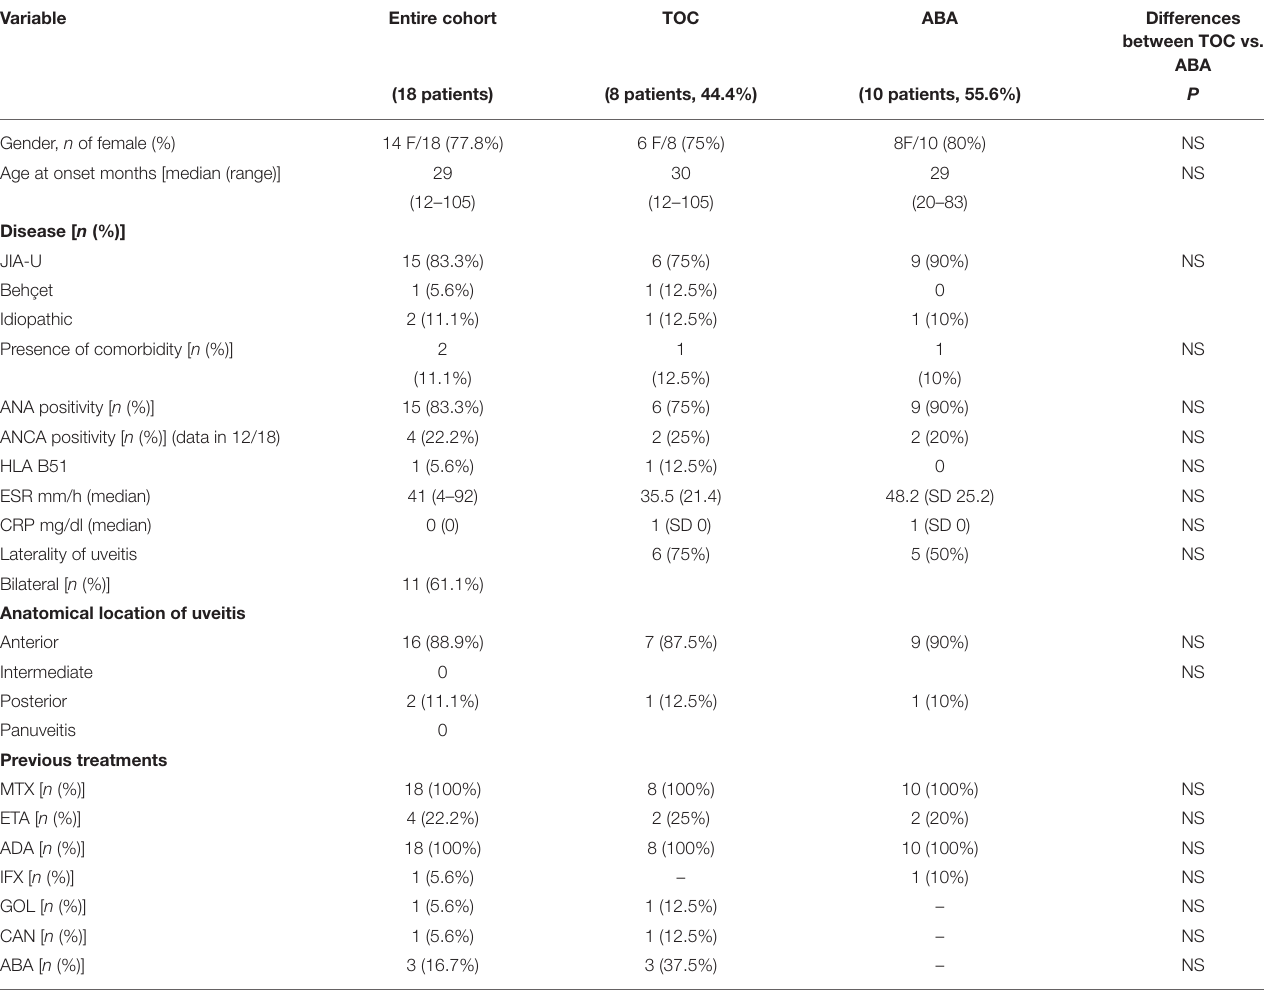
TABLE 1 | The demographic and clinical characteristics of population in study. Variable Entire cohort TOC ABA Differences